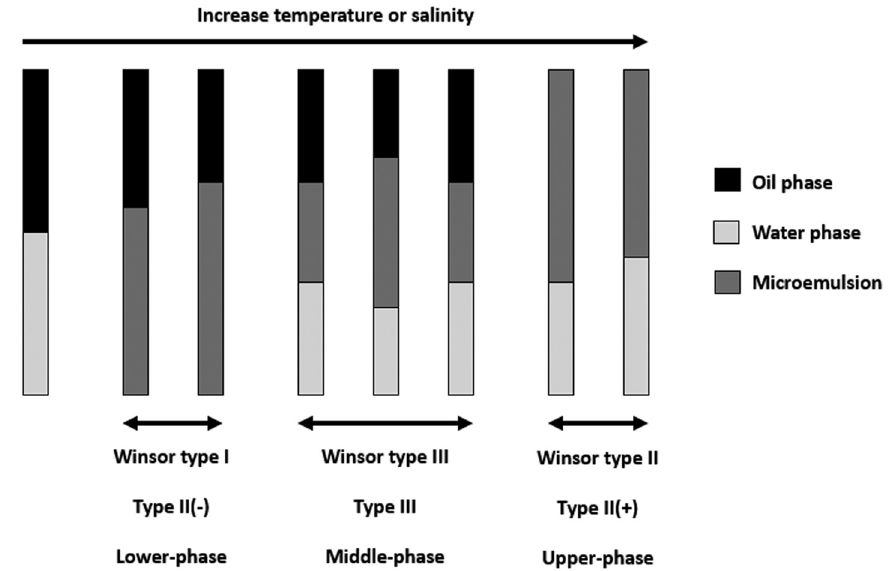
Figure 3: Schematic of microemulsions in surfactant